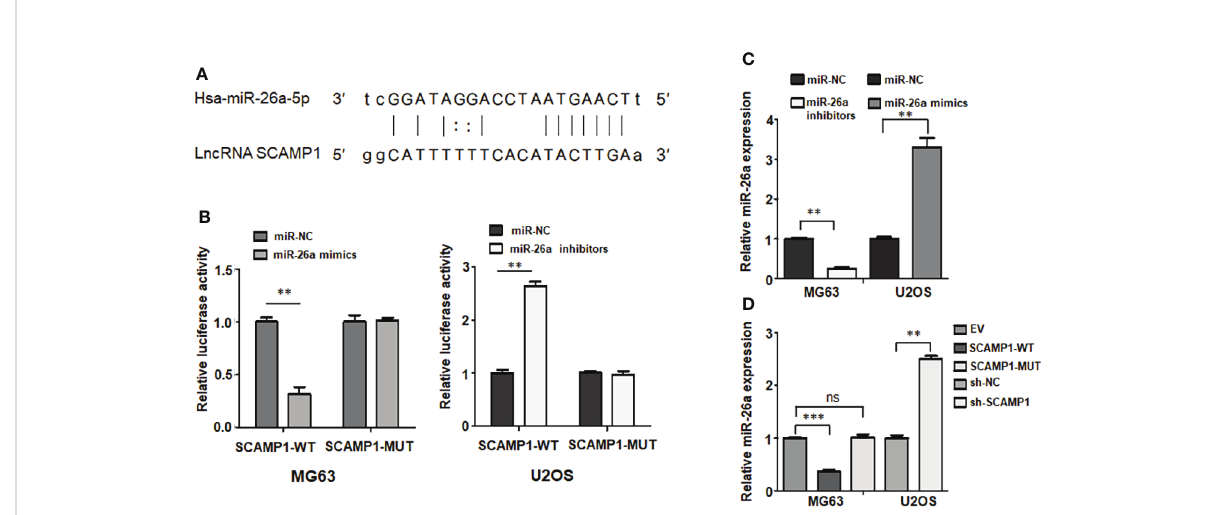
FIGURE 4 LncRNA SCAMP1 interacts with and regulates miR-26a-5p in osteosarcoma cells. (A) : Potential binding sites between miR-26a-5p and lncRNA SCAMP1. (B) : Dual luciferase reporter assays showed that miR-26a interacted with lncRNA SAMP1. miR-26a-5p modulation regulated luciferase activity in SCAMP1 wild-type group. (C) : RT-PCR data showed that miR-26a inhibitors decreased the expression of miR-26a-5p in MG63 cells, while miR-26a mimic transfection increased the miR-26a-5p expression levels in U2OS cells. (D) : RT-PCR data showed that upregulation of SCAMP1 suppressed the expression of miR-26a-5p in MG63 cells, while sh-SCAMP1 increased miR-26a-5p expression in U2OS cells. SCAMP1- WT: SCAMP1 wild type; SCAMP1-MUT: SCAMP1 mutant. **P < 0.01; ***P < 0.001 vs control group; ns, no signi fi